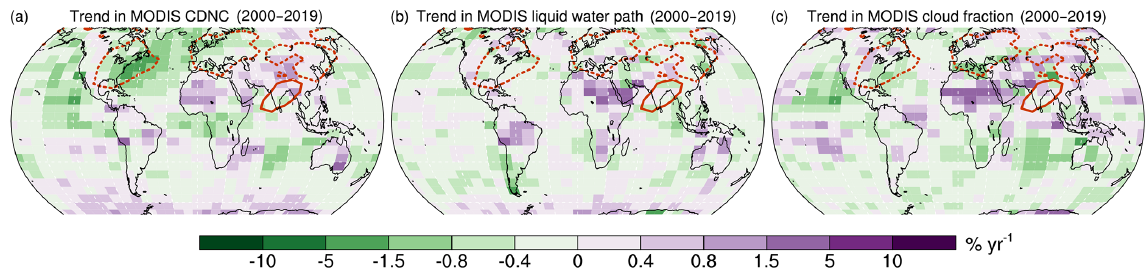
Figure 3. Linear trends (2000–2019) in cloud properties retrieved for liquid-water clouds from MODIS (Platnick et al., 2017) where cloud droplet number concentration (CDNC, a ) and cloud liquid water path (LWP, b ) are computed assuming adiabatic clouds (Quaas et al., 2006; Grosvenor et al., 2018); (c) liquid cloud fraction. Isolines as in Fig. 1. A figure that shows the trends in absolute units is provided as Supplement.